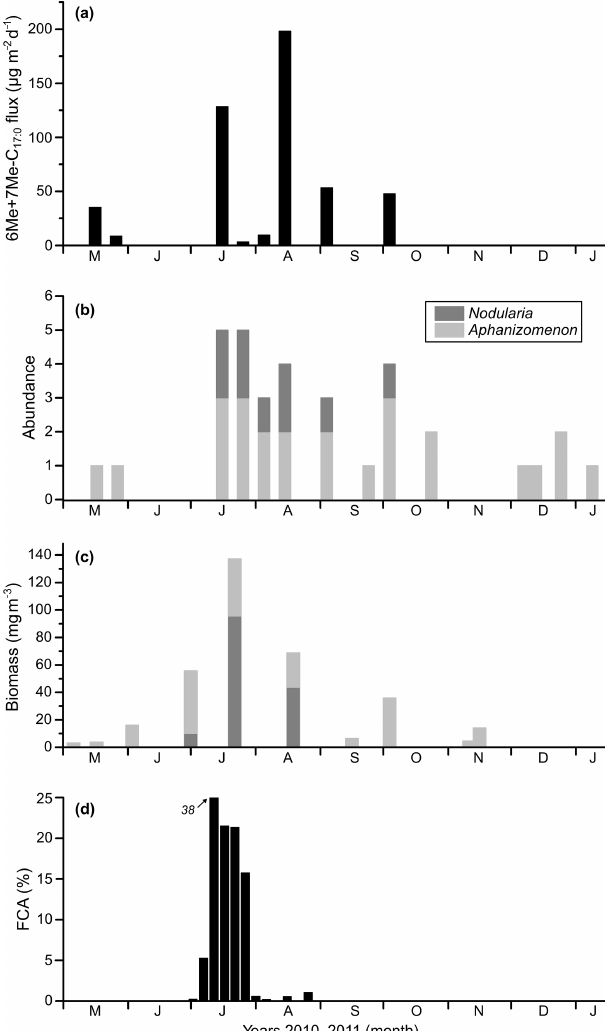
Figure 3. May 2010 to January 2011 fluxes of the sum of 6Me- C 17 : 0 and 7Me-C 17 : 0 (6 + 7Me-C 17 : 0 ) (a) , relative abundance (1: present; 2: abundant; 3: highly abundant; bars are stacked) of Nodu- laria spumigena and Aphanizomenon sp. cyanobacteria in sediment trap material from the eastern Gotland Basin (b) , biomass data of Nodularia spumigena and Aphanizomenon sp. cyanobacteria from monitoring stations located in the eastern Gotland Basin (Fig. 1) (c) , and the FCA (frequency of cyanobacteria accumulations) index (d) . The data are listed in Table